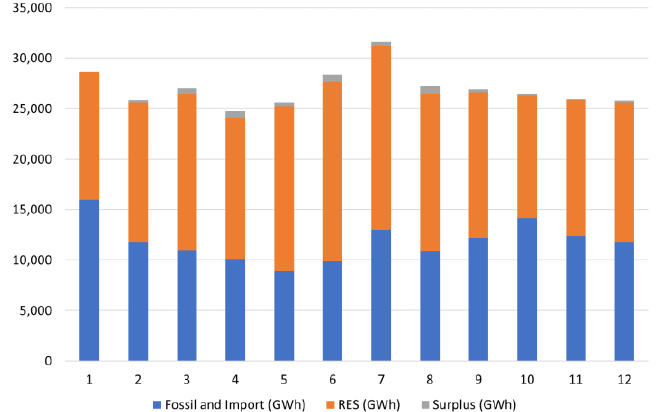
Figure 5. Case 1 monthly energy production from renewables, from fossil fuel and imports, and renewable energy surplus with thrice the production from photovoltaic and twice the production from wind.